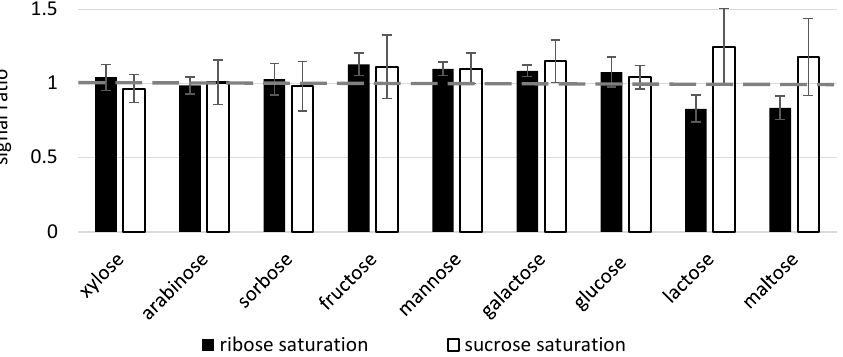
Figure 7. Matrix effects between sugars at a larger injection-liner volume. Recovery of nine sugars (120 µM) in presence of ribose and sucrose in saturation (5 mM). Analyzed on the Trace Focus GC.